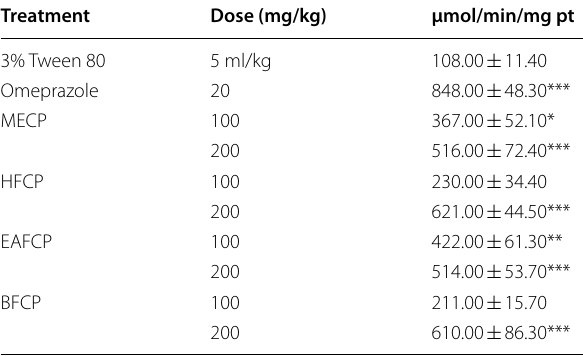
Values are expressed as mean